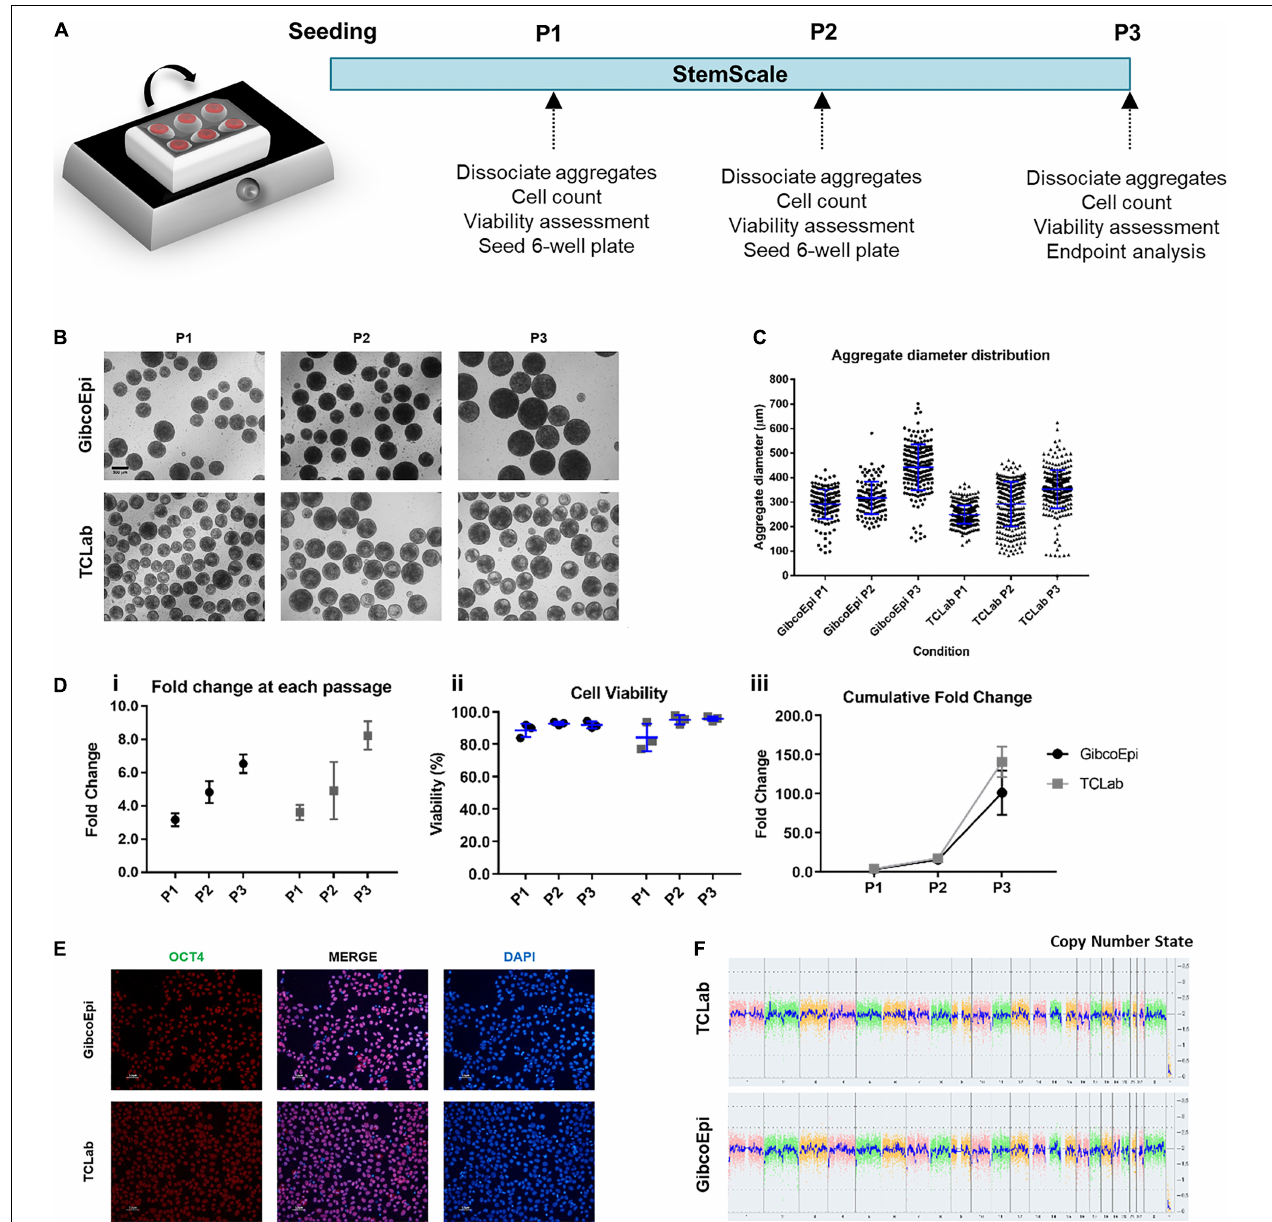
FIGURE 1 | Expansion of hiPSCs under agitated conditions using an orbital shaker. (A) Schematic overview of hiPSC expansion on orbital shaker using StemScale. (B) Bright Field images of 3D aggregates before P1, P2 and P3 for GibcoEpi and TCLab cells lines. Scale bars: 300 µ m. (C) Distribution of hiPSC aggregate diameters obtained using StemScale before P1, P2 and P3. (D) Fold change (i) , cell viability (ii) and cumulative fold change (iii) of hiPSC at P1, P2 and P3. (E) Immunocytochemical analysis of hiPSC obtained after three passages on orbital shaker and 48 h days after replating in Matrigel-coated plates for Oct4 expression. Nuclei were stained with DAPI. Scale bars: 50 µ m. (F) At the end of three passages, the karyotypic analysis remained